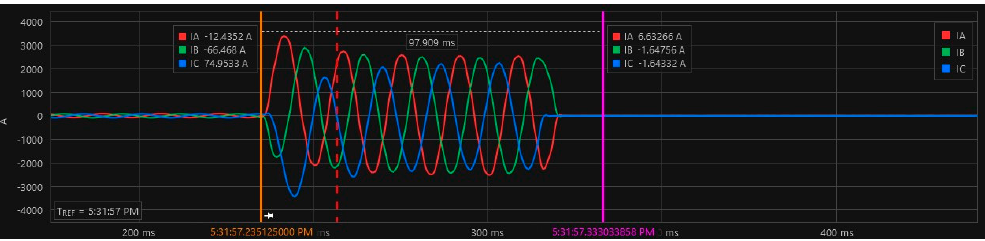
Figure 33. Phase currents recorded by R1 under definite-time scheme.